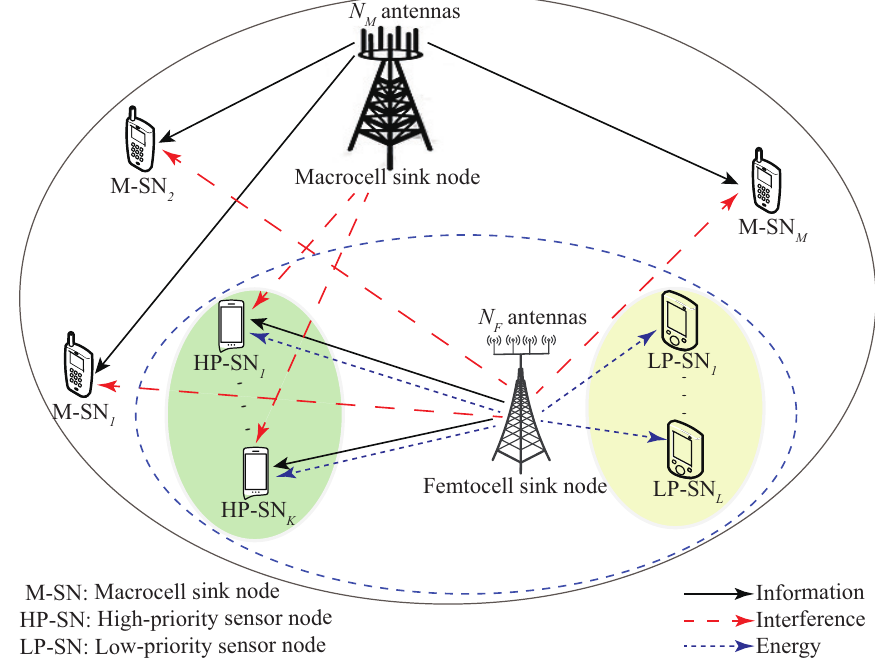
Figure 1. The system model of MIMO Secured HWSN with